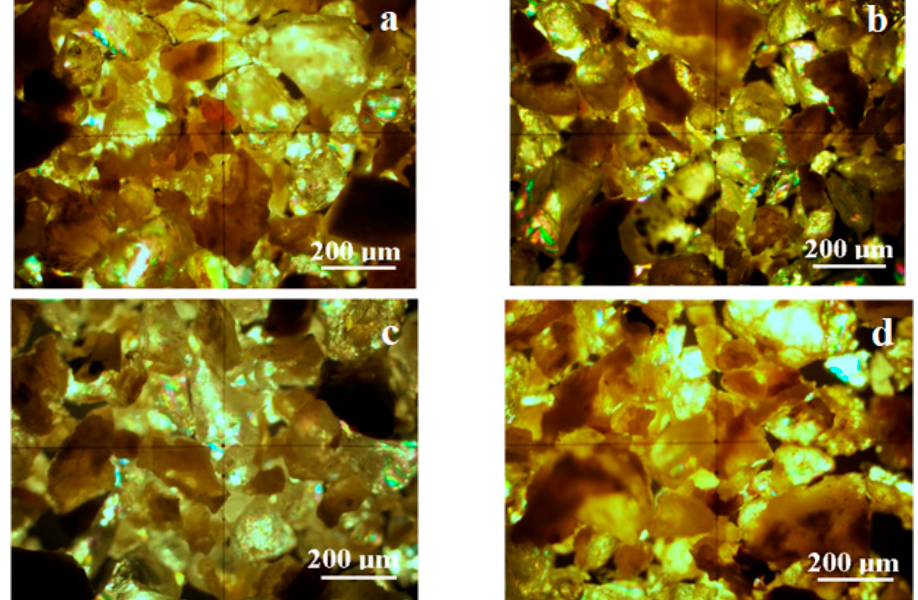
Figure 11. Cross-polarized light mineralogical microscopy images for structural layer: ( a ) control group; ( b ) rainwater; ( c ) acetic acid solution; ( d ) sulfuric + nitric acid solution. Several green particles presented intense green light iridescence as small spots of submicron size. These spots signal the presence of submicron features on a quartz particle surface. Some yellow-brown particles with diameters of around 50 µm are observed; these are traces of calcite naturally occurring in the sand. The dark areas in Figure 4b appear due to amorphous material such as glass fiber particles and polymers crusts. The data obtained by CPOM are centralized in Table 4. Table 4. Properties of minerals from exterior area and structural layer.